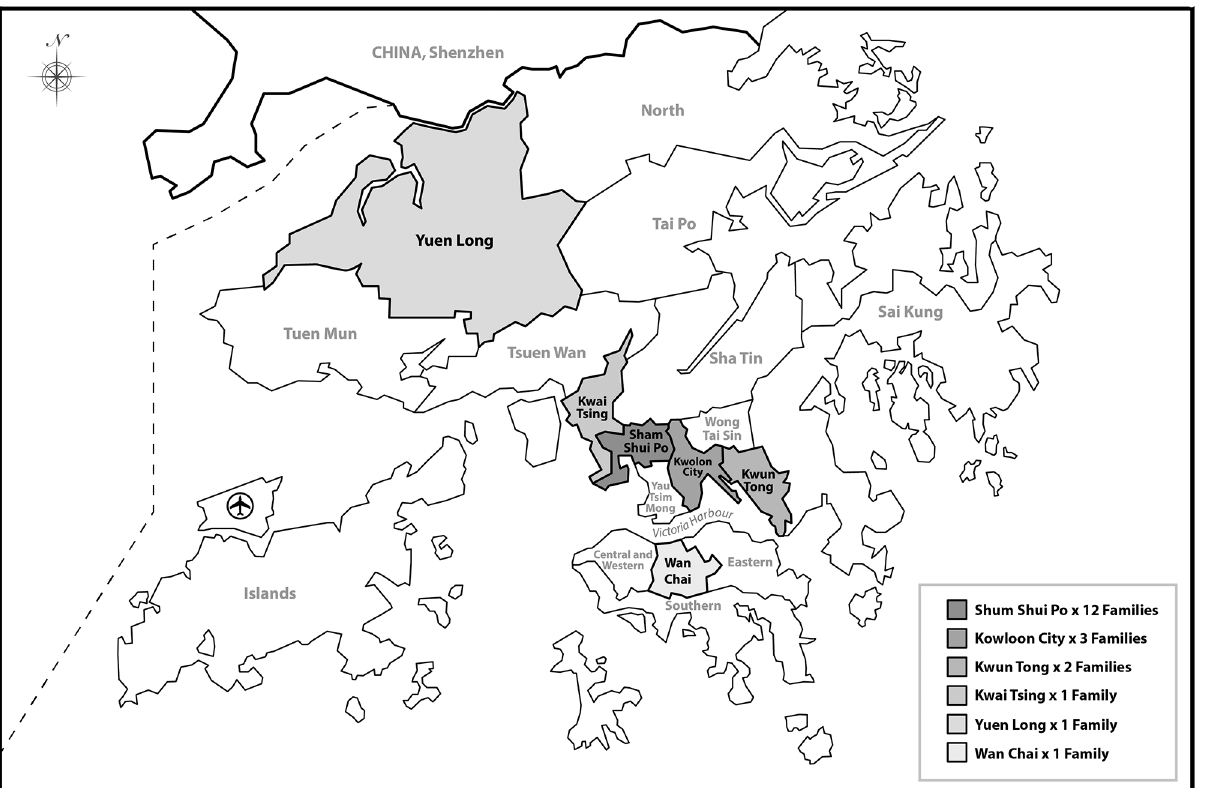
Fig 1. The location of 18 districts in Hong